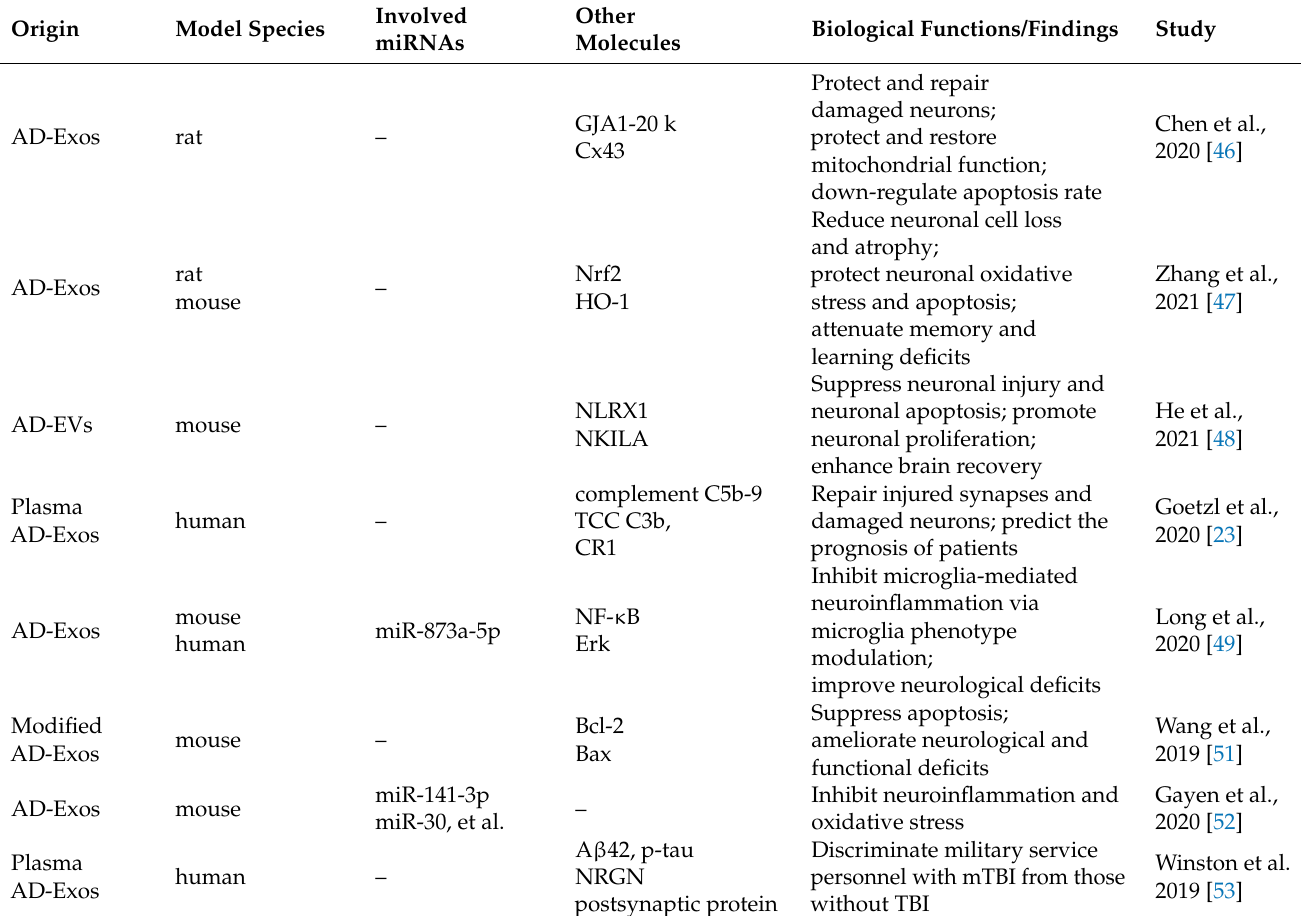
Table 2. Astrocyte-derived Exos/EVs and AD-Exos/EVs-miRNAs studies in